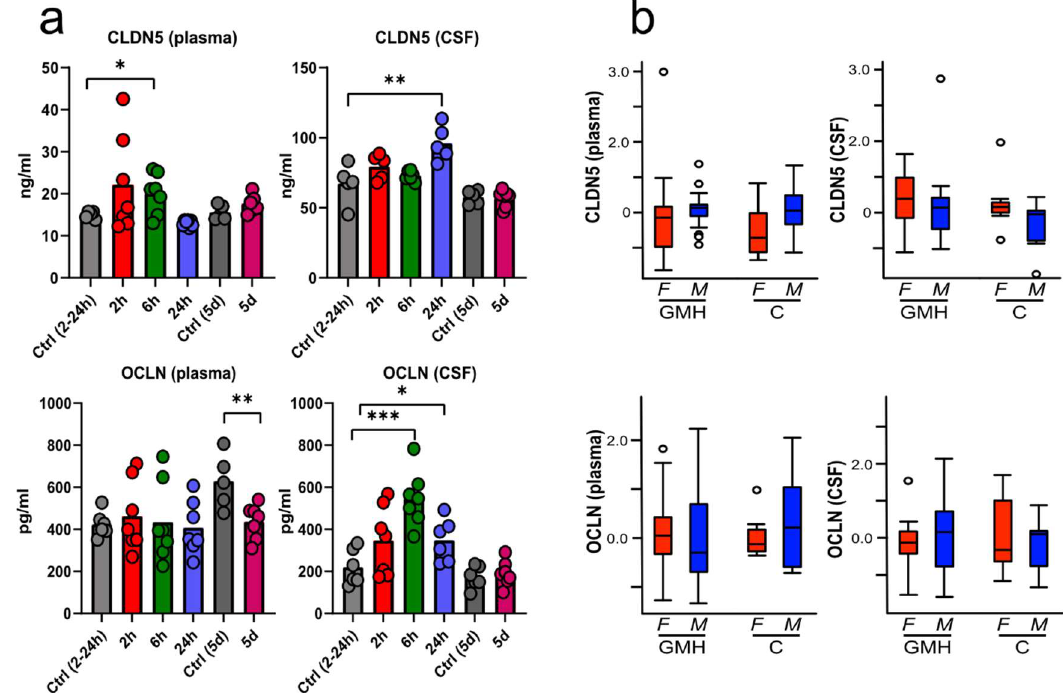
Figure 4. Time-dependent changes of tight junction protein levels in blood plasma and cerebrospinal fluid after GMH. The levels of CLDN5 and occludin (OCLN) was measured using ELISA at 2 h, 6 h, 24 h and five days after GMH, as well as time-matched control animals ( a ). Sex effect of CLDN5 and OCLN animals were investigated by pooling all samples from GMH and control (C) animals and adjusting levels for time. No difference was seen between male (M) and female (F) pups ( b ). Data was analysed by unpaired t -tests and one-way ANOVA with Dunnett’s multiple comparison test, * p ≤ 0.05, ** p ≤ 0.01, and *** p ≤ 0.001. n = 6 (control groups) or 7 (GMH-groups) for all time-points. Bar graphs represent mean values; box-plots showing median, quartiles, range (whiskers) and outliers (open circles, 1.5* quartile).